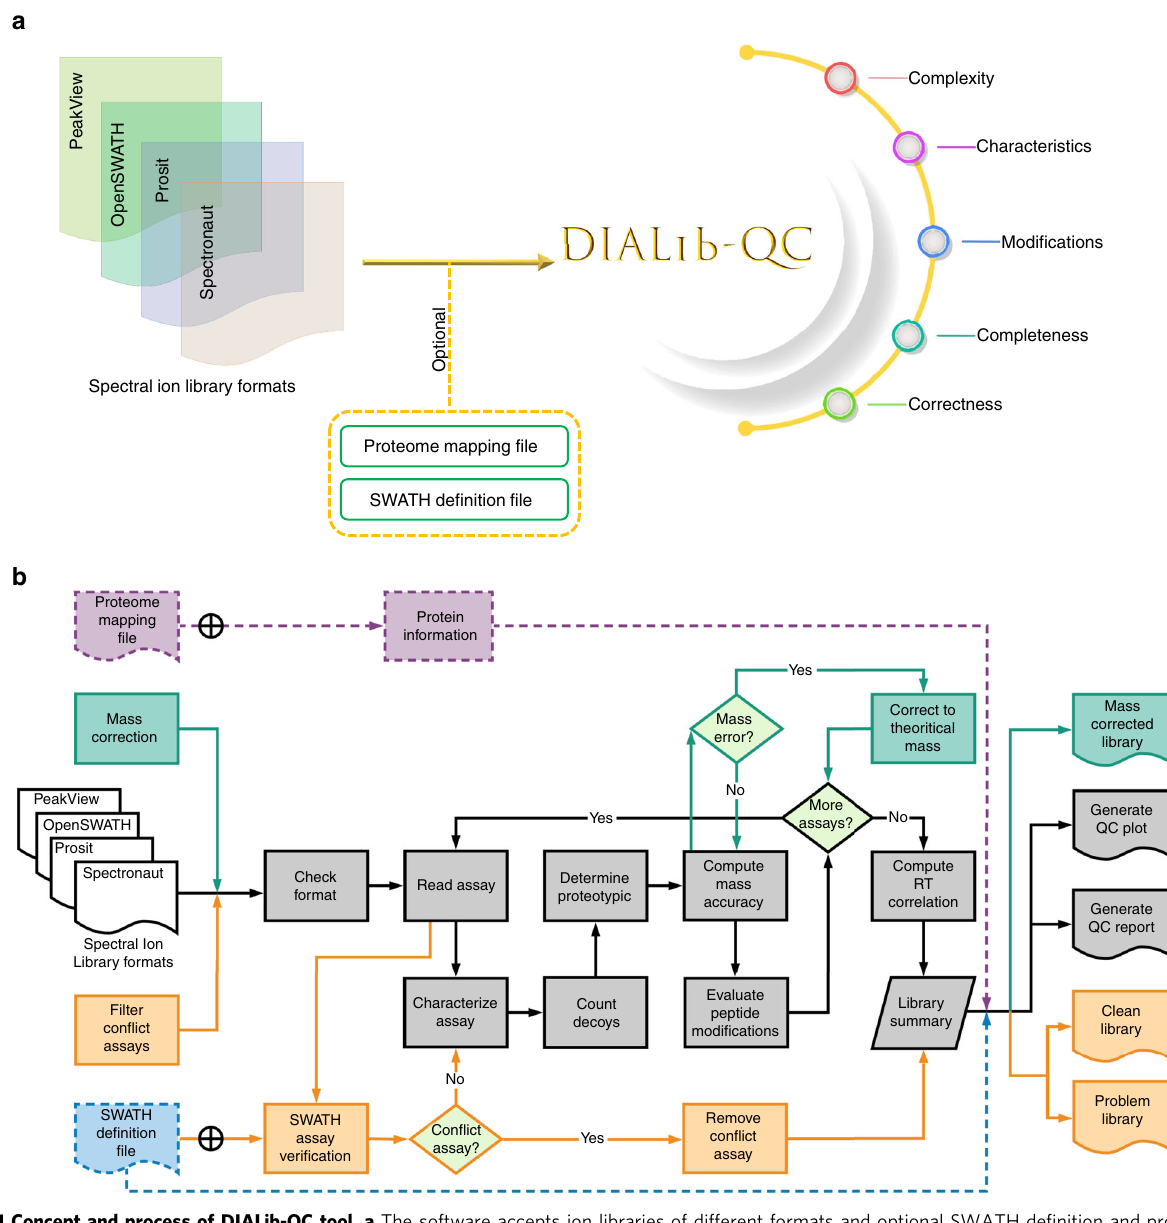
Fig. 1 Concept and process of DIALib-QC tool. a The software accepts ion libraries of different formats and optional SWATH de fi nition and proteome mapping fi les as input. DIALib-QC assesses DIA ion libraries based on 62 criteria that can be broadly organized in fi ve categories. The correctness category can further be used for repairing an ion library. b The fl owchart describes the process of the DIALib-QC tool, available at www.swathatlas.org. The work fl ow in black solid lines shows all functions to analyze an assay library and generates an assessment report and graphical summary plots. Mass correction (green solid lines) and fi ltering con fl ict assays (orange solid lines) functions are tandem features that generate a new library. Using the mass correction parameter results into a mass corrected library while using the fi lter con fl ict assays parameter segregates the query library into a problem (containing only con fl ict assays) and a clean (error-free) library. The proteome mapping fi le (purple dashed line) and SWATH de fi nition fi le (blue dashed line) are optional input fi les which provide information related to peptide/protein characteristics and help to asses con fl ict assays, respectively. DIALib-QC evaluates systematically different library characteristics and generates a report highlighting attributes that may impact the identi fi cation and quanti fi cation of